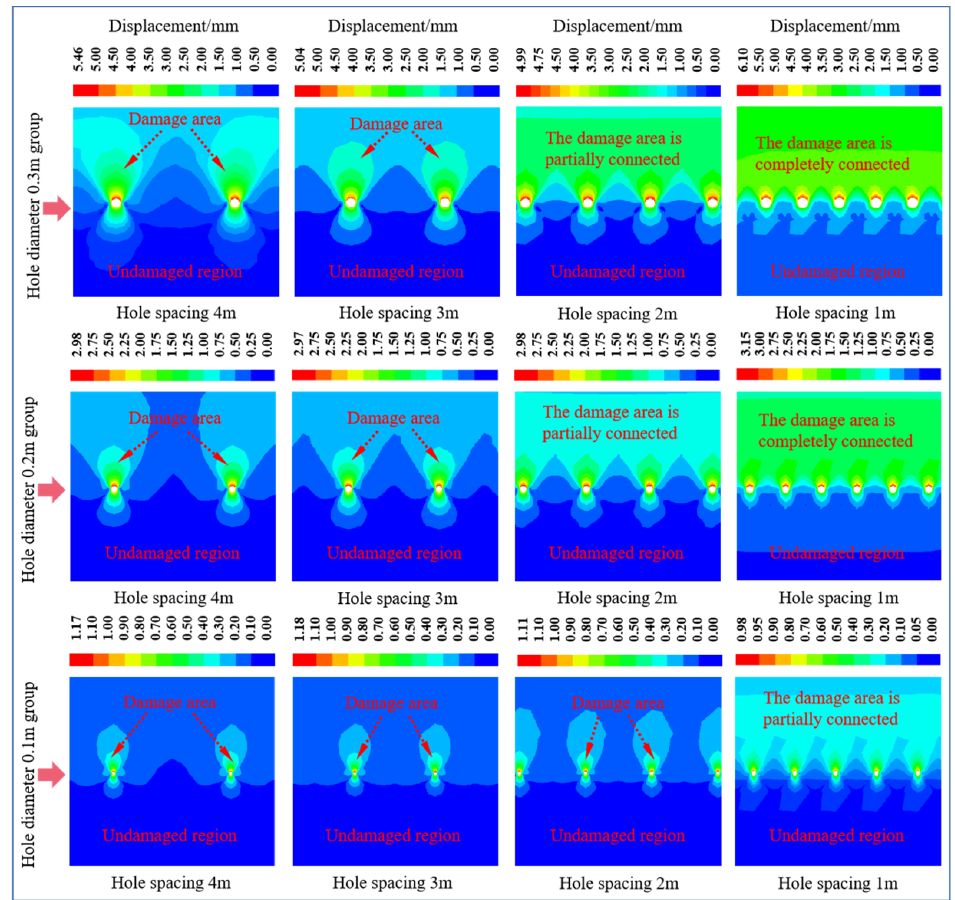
Figure 11. Displacement evolution between boreholes with different hole diameters and hole spacings.